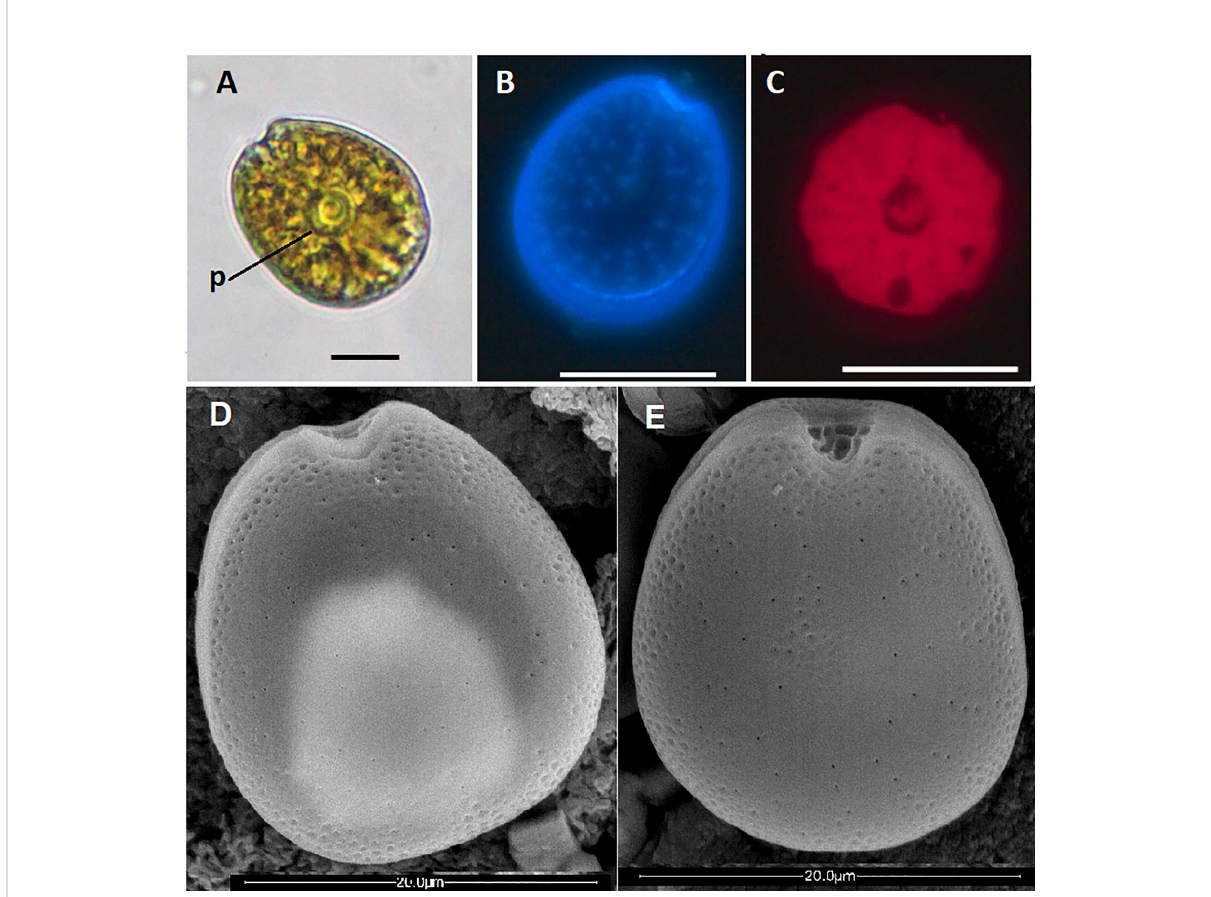
FIGURE 2 Prorocentrum borbonicum : light micrographs (A − C) and scanning electron micrographs (D, E) . (A) Live cell, in right lateral view, p= pyrenoid, scale bar 10 m m. (B) Left thecal plate showing large thecal pores and (C) Chloroplasts. Scale bars 20 m m. (D) Cell in left lateral view and (E) Cell in right lateral view showing depressions, pores, and V-shaped peri fl agellar area. Scale bars 20 m